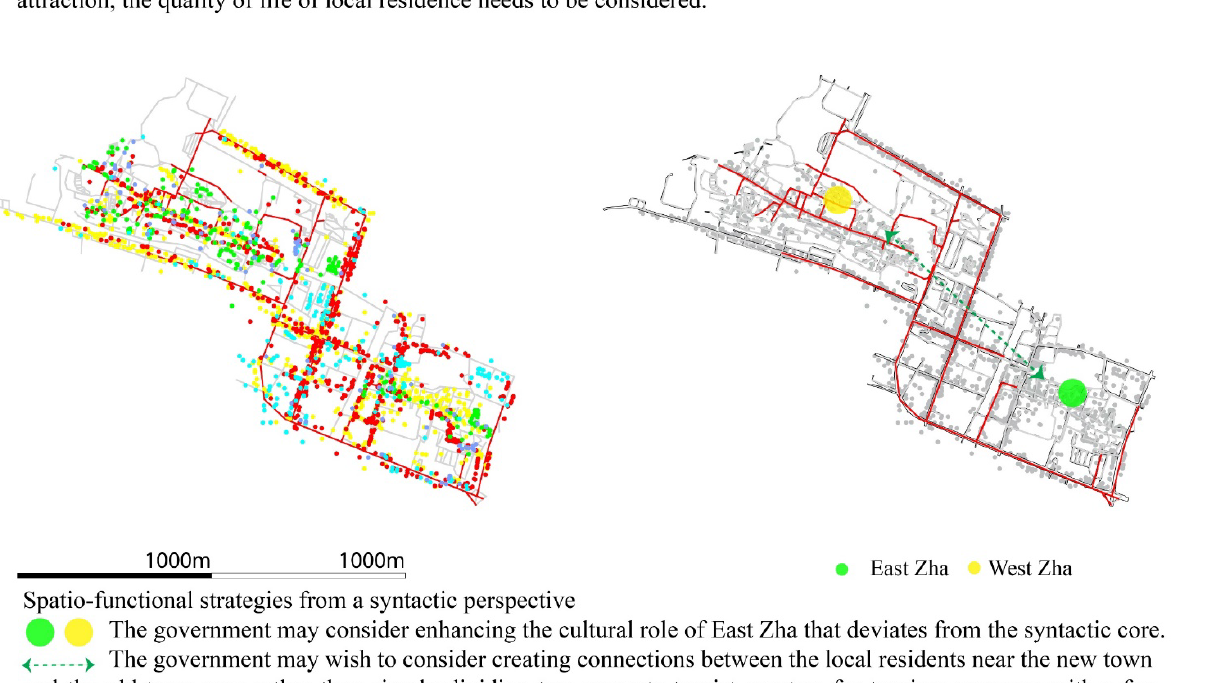
Figure 15. The strategies suggested for Kulangsu and Wuzhen based on the spatio-functional analysis results.